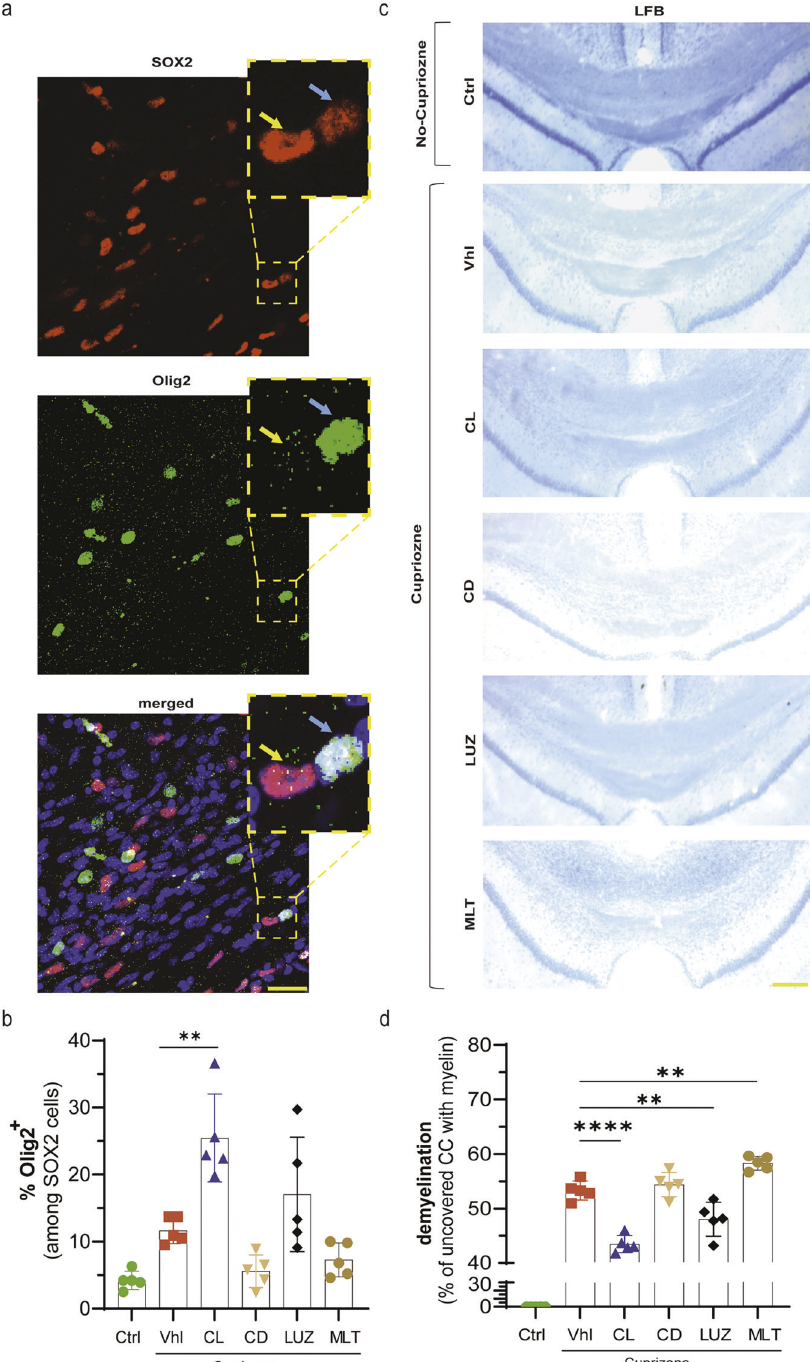
Fig. 5 Olig2 recruitment to the demyelinated site and restoration of the myelin sheath. a Fluorescent staining of Olig2, an oligodendroglia marker, and SOX2, which is expressed by Olig2 cells, increased the recruitment of Olig2 + cells to the site of injury. b Quanti fi cation of the frequency of SOX2-expressing Olig2 cells (SOX2 + /Olig2 + ). The blue arrow indicates SOX2 + /Olig2 + , and yellow indicates SOX2 + /Olig2 - . c LFB staining of the corpus callosum to measure the extent of demyelination. d Quanti fi cation of the percentage of the uncovered area of the corpus callosum, which indicates the demyelinated area. Olig2, SOX2 and LFB quanti fi cations were performed in the same area of the corpus callosum. The blue arrow shows Olig2-expressing SOX2 cells, and the yellow arrow shows SOX2 lacking Olig2 expression ( n = 5 mice/group; 3 slides per mouse). Signi fi cance is indicated by ∗∗ p < 0.01 and ∗∗∗ p < 0.0001. Scale bars, 20 μ m in a ; 100 μ m in c